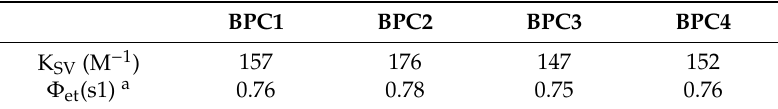
Figure 7. ( a ) Fluorescence quenching of BPC1 by Iod in acetonitrile; ( b ) Stern-Volmer treatment for BPC1 / Iod fluorescence quenching. Table 3. Some parameters of BPC1-BPC4. K SV (M − 1 ) Stern-Volmer coef fi cients for PI/Iod systems, Φ et (s1) PI/Iod electron transfer quantum yields in the excited singlet state .